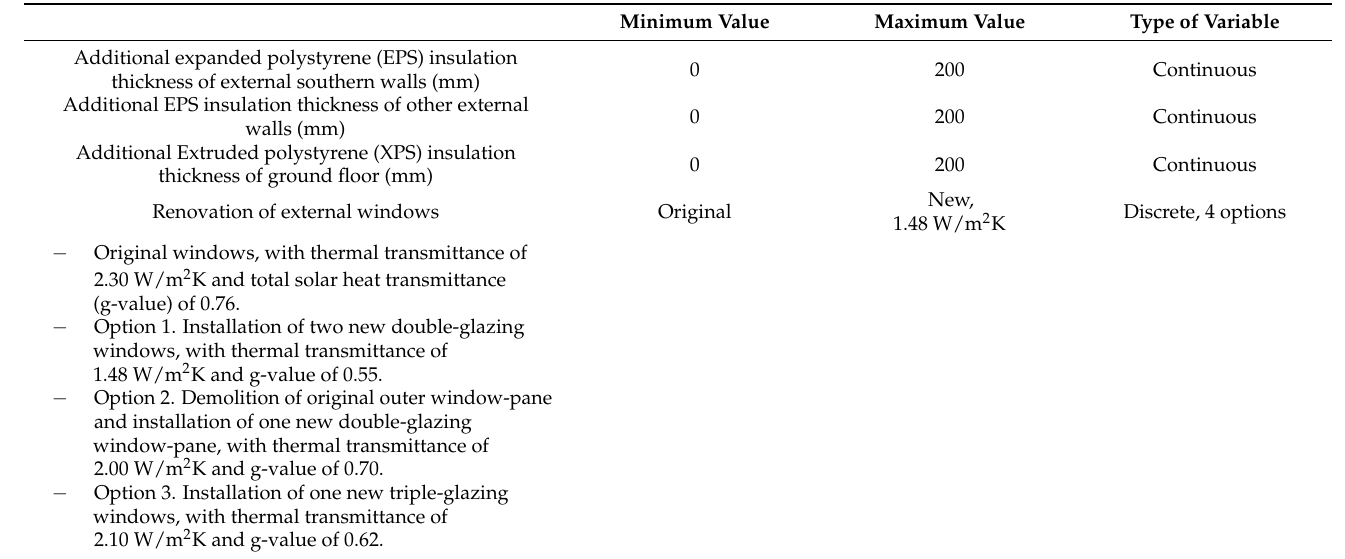
Table 3 lists the ranges and types of decision variables of each renovation measure. Table 3. Decision variables of renovation measures used in SBMO